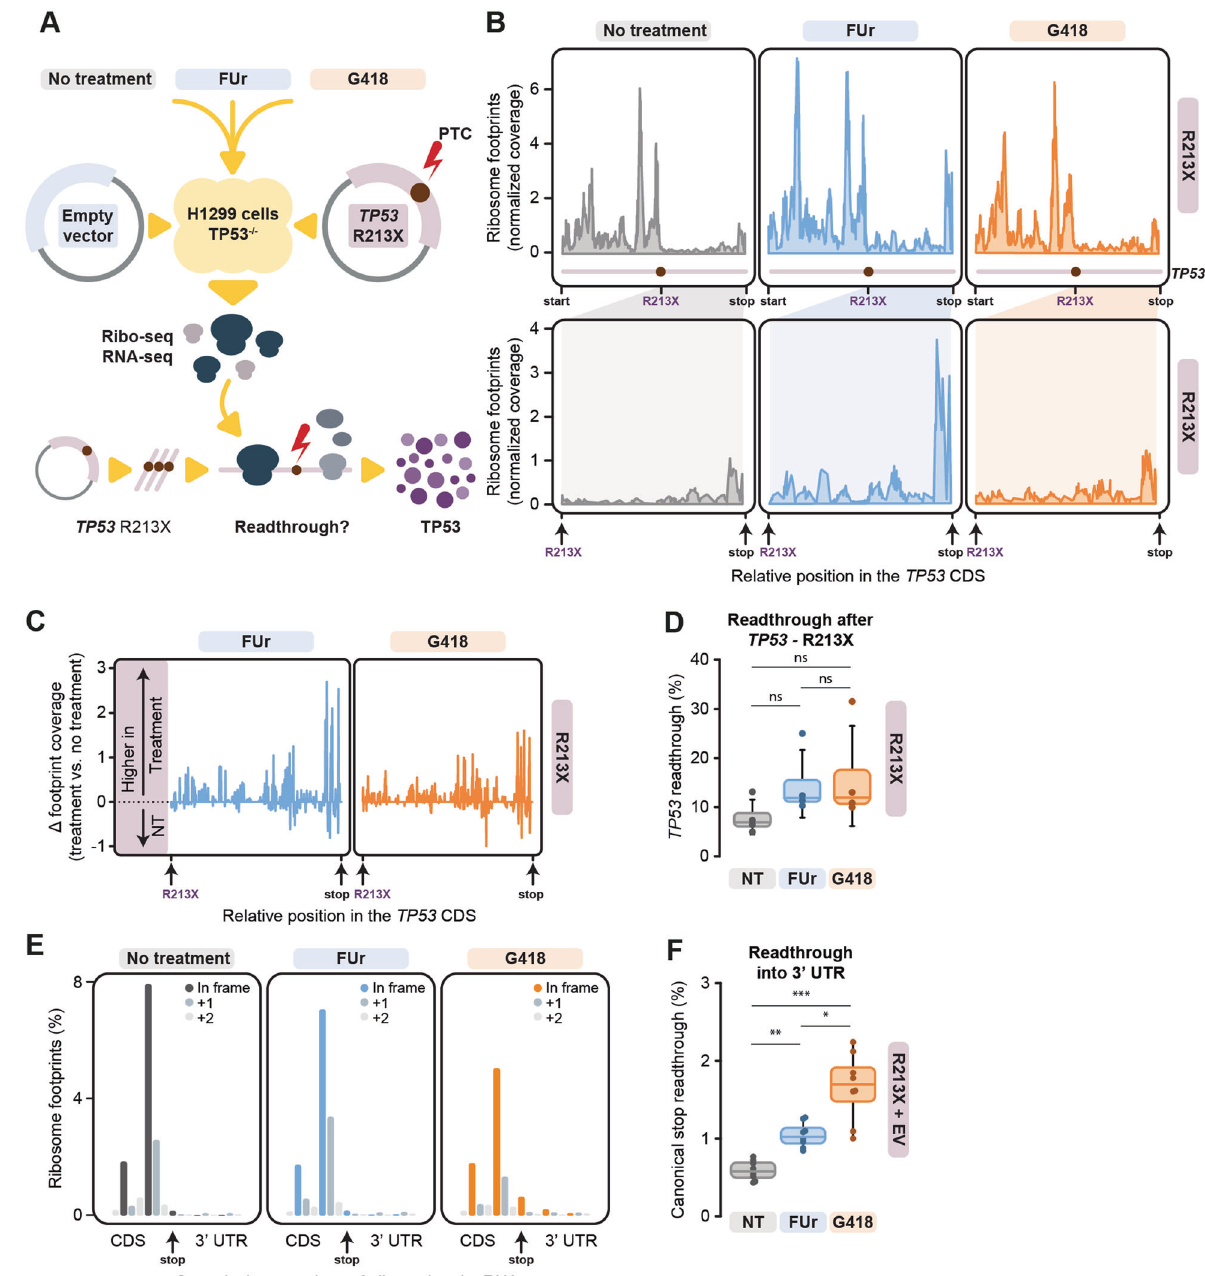
Fig. 3 Ribosome pro fi ling supports induction of translational readthrough by FUr. A , Schematic overview of the Ribo-seq experiments. B , Line plots of normalised Ribo-seq read coverage across the entire TP53 CDS (top) and a zoomed view of the region between R213X and the canonical TP53 stop codon (bottom). Locations of start and stop positions and premature termination codon R213X are annotated. C , Segment plots of relative Ribo-seq read coverage of TP53 between the premature termination codon R213X and the canonical stop codon. Positive and negative values indicate coverage changes in H1299-R213X cells upon treatment with either FUr or G418 in comparison to untreated cells. D , Box plot of premature R213X stop codon readthrough ratios observed by Ribo-seq. Ratios were calculated by taking the sum of all in-frame reads after the R213X premature stop until the canonical stop codon and dividing it with the sum of all in-frame reads from the canonical start position until the premature stop codon, normalized for CDS codon length ( see Methods ), N = 4. Statistical analyses were performed comparing all conditions to each other using Friedman test followed by Dunn ’ s multiple comparisons test as data did not fi t normal distribution (ns = not signi fi cant). E , Metagene bar plot showing footprint coverage around the stop codons of annotated reading frames of all translated protein-coding genes. F , Box plot of stop codon readthrough ratios on a metagene level, as determined by Ribo-seq per treatment condition. Ratios were calculated by taking the sums of in-frame reads after the stop codon and dividing these with the sums of in- frame reads before the stop codon, both normalised for feature length. Replicate experiments in H1299-EV and H1299-R213X cells were merged per treatment type for this visualization, N = 8. Statistical analyses were performed comparing all conditions to each other using repeated measures one-way ANOVA followed by Tukey ’ s multiple comparisons test (* p ≤ 0.05, ** p ≤ 0.01, *** p ≤ 0.001). In D and F , each dot represents a replicate experiment. Data are represented as median ± 95% con fi dence interval, box limits represent the upper and lower